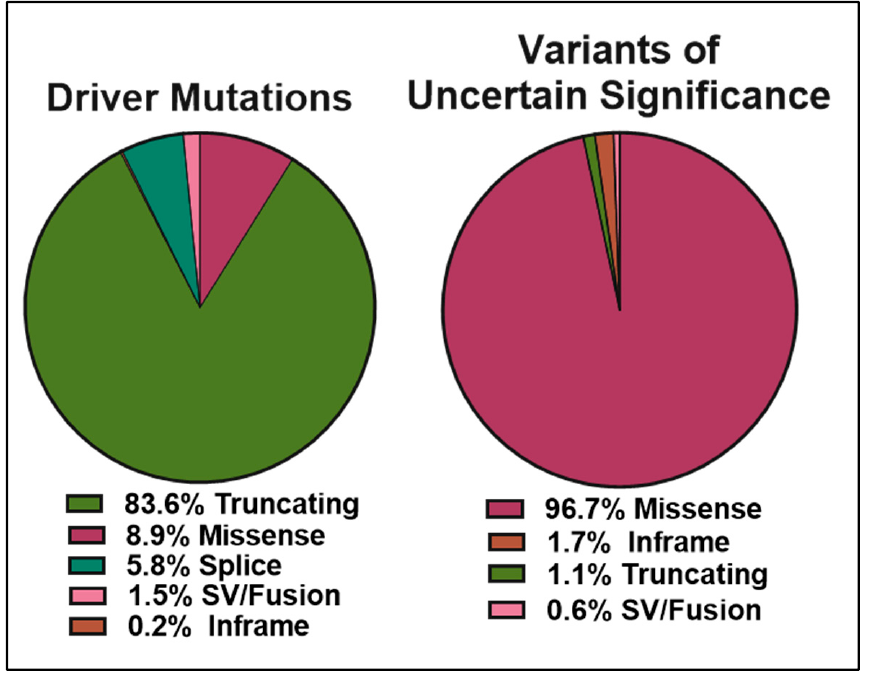
Figure 5. Pie charts representing the percentages of BRCA2 germline and somatic genetic variants grouped into driver mutations (left) and VUS (right) as reported in cBioPortal for Cancer Genomics database (https://www.cbioportal.org/results/cancerTypesSummary?tab_index=tab_visualize&Action=Submit&session_id=607f022de4b0242bd5d49461, accessed on 10 April 2021). The curated set of non-redundant studies of cBioPortal for Cancer Genomics was used. A total of 48,081 samples and 184 studies. The total number of driver mutations and variants of uncertain significance (1934) corresponds to 3% of the samples with BRCA2 somatic mutations and <0.1% of the samples with BRCA2 germline mutations.